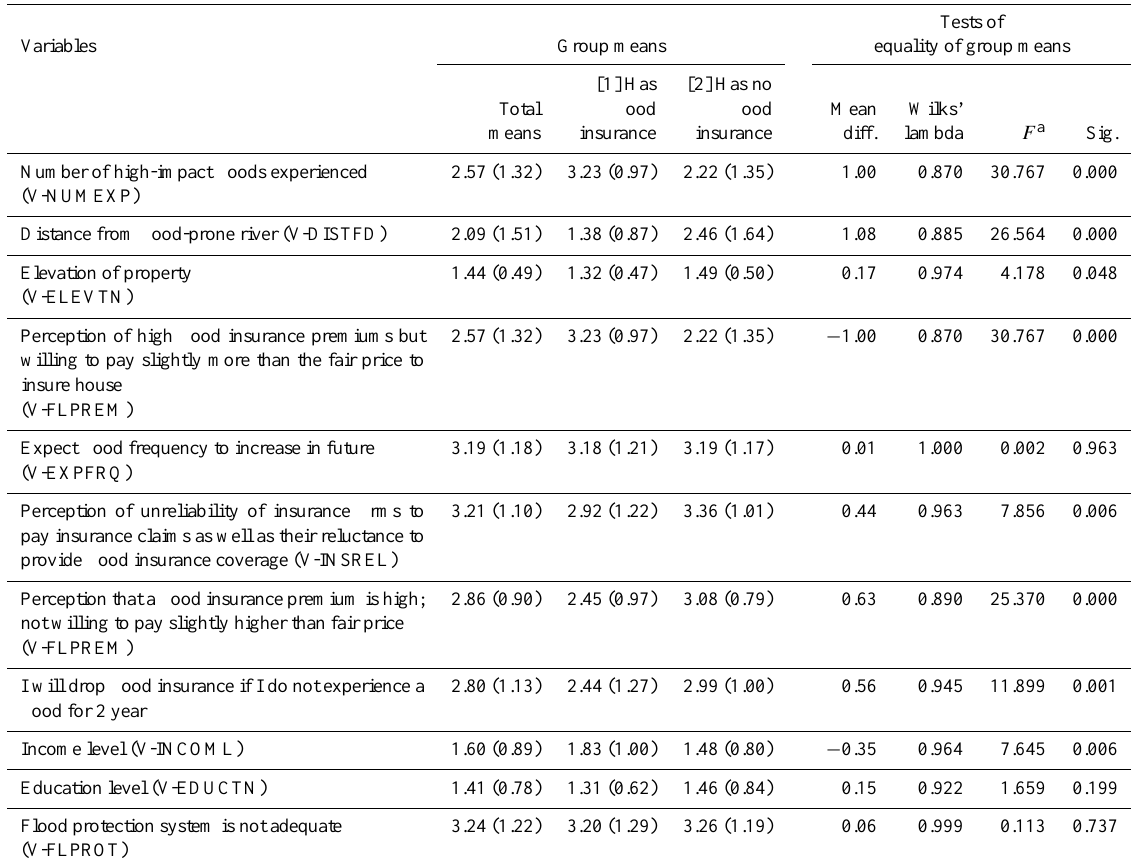
Table 1. Group mean differences and tests of equality of group means. Tests of Variables Group means equality of group means [1] Has [2] Has no Total flood flood Mean Wilks’ means insurance insurance diff. lambda F a